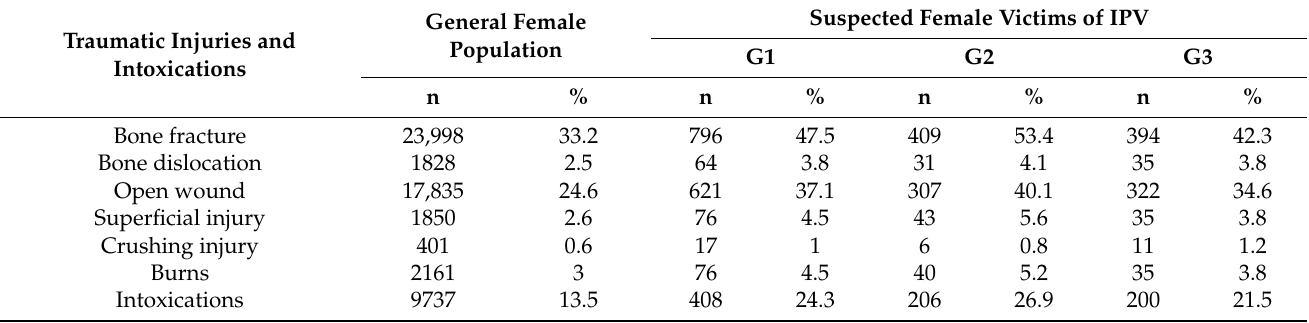
Table 3. Victims’ history of traumatic injuries and intoxications (medicolegal aetiology unknown).